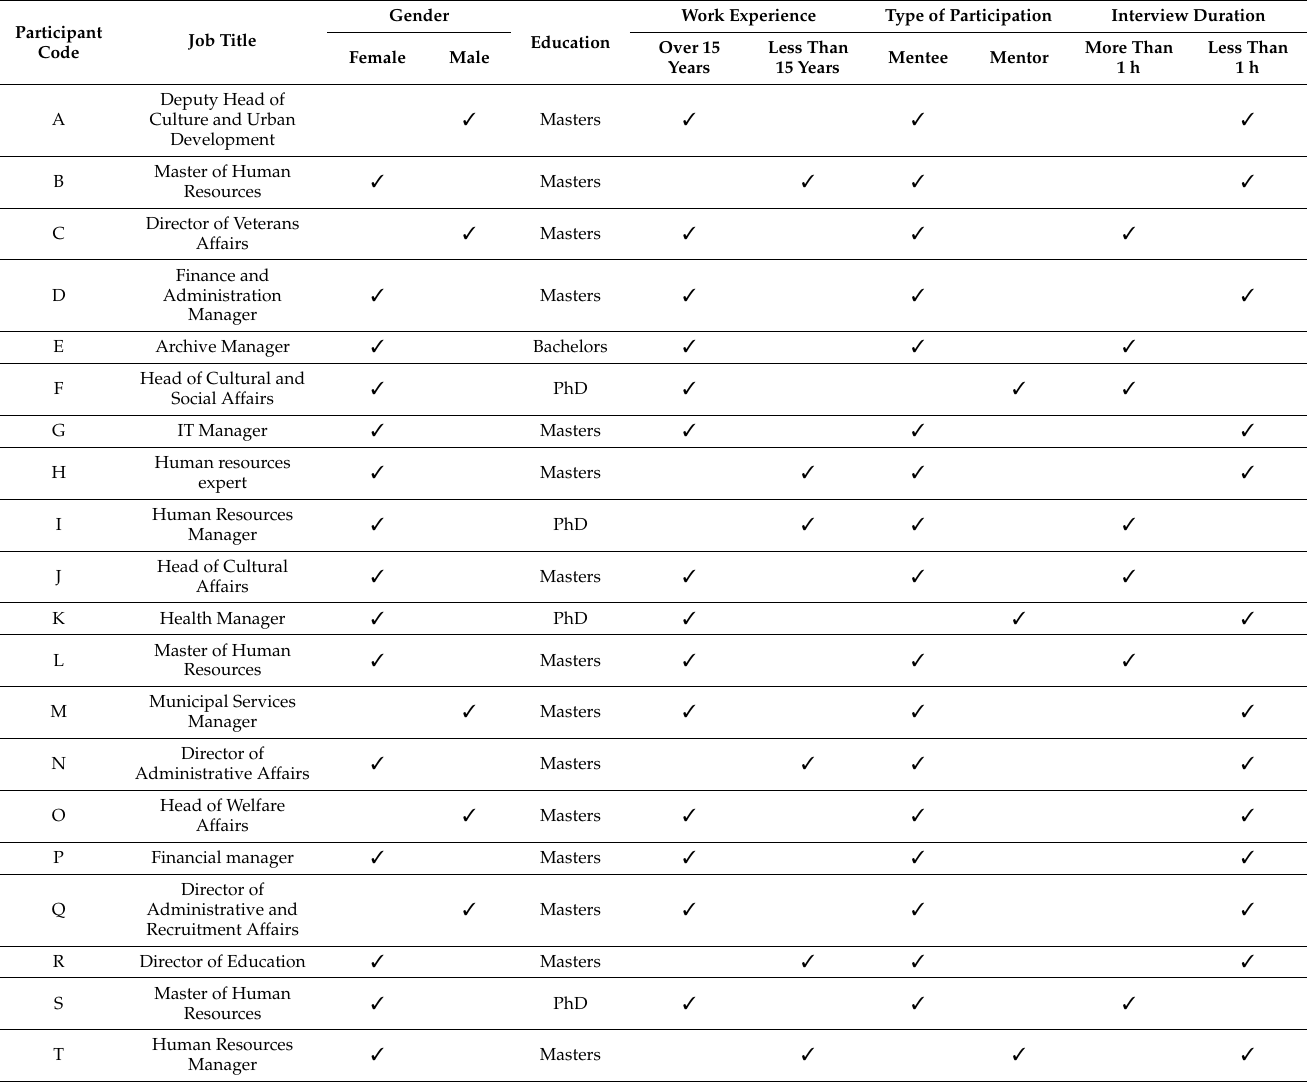
Table A1. Profiles of the